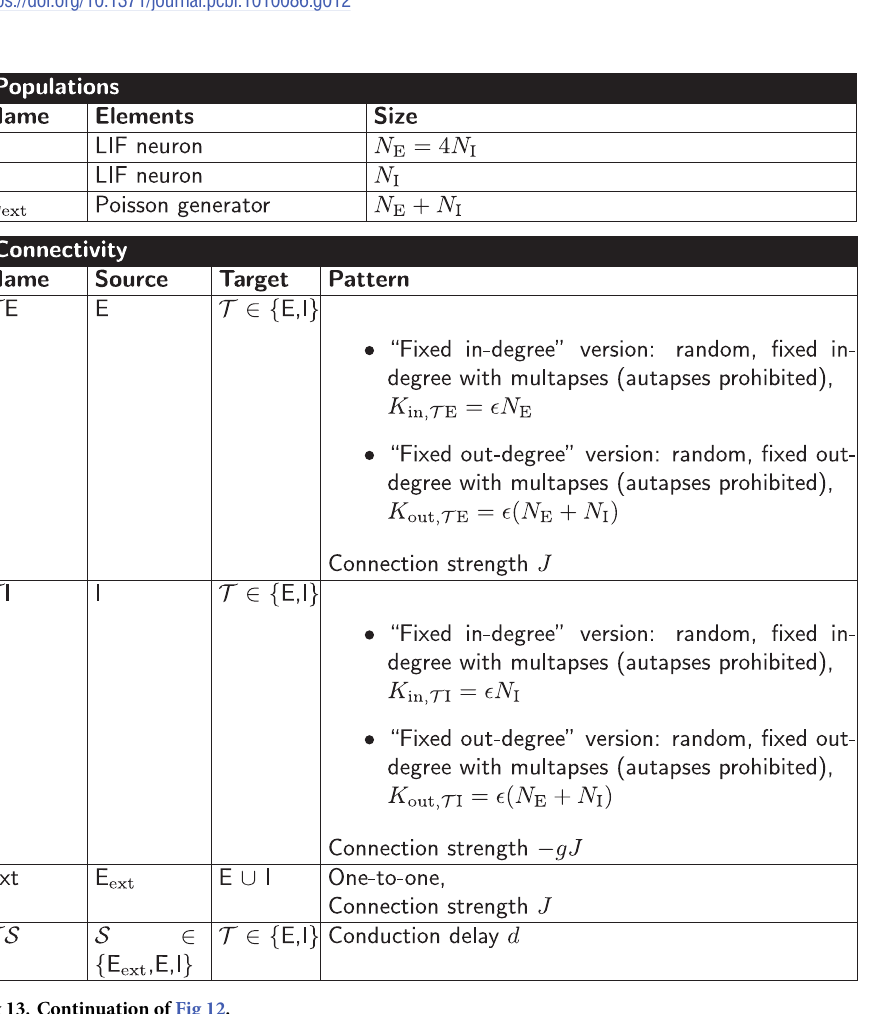
Fig 12. Description of balanced random network models following the guidelines of Nordlie et al. [84]. Distinction between “fixed in-degree” and “fixed out-degree” versions.